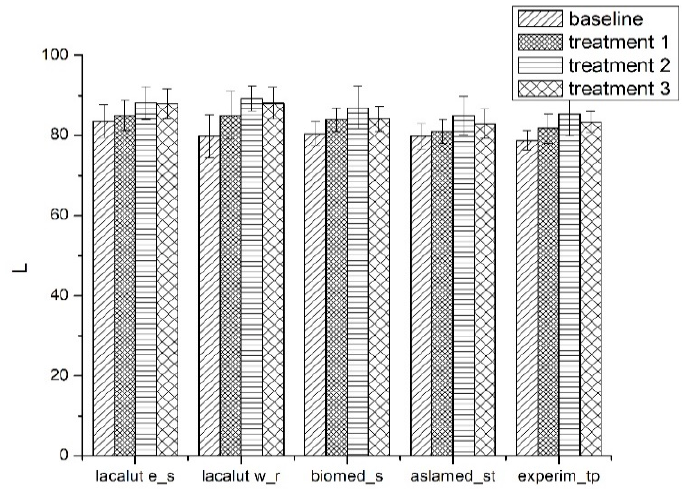
Figure 2. Average values and standard deviations of L* parameter during experimental phases.